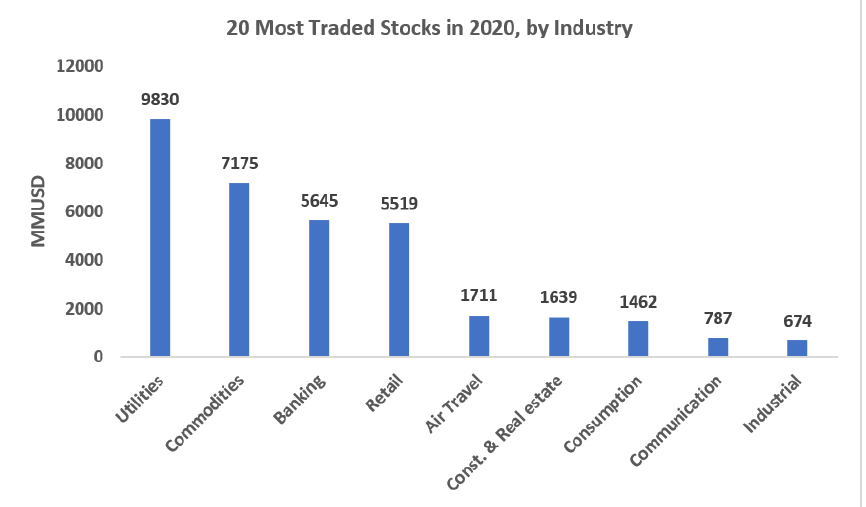
Figure 1. Twenty most traded shares in 2020, shown by industry. Source: Authors’ own elaboration.